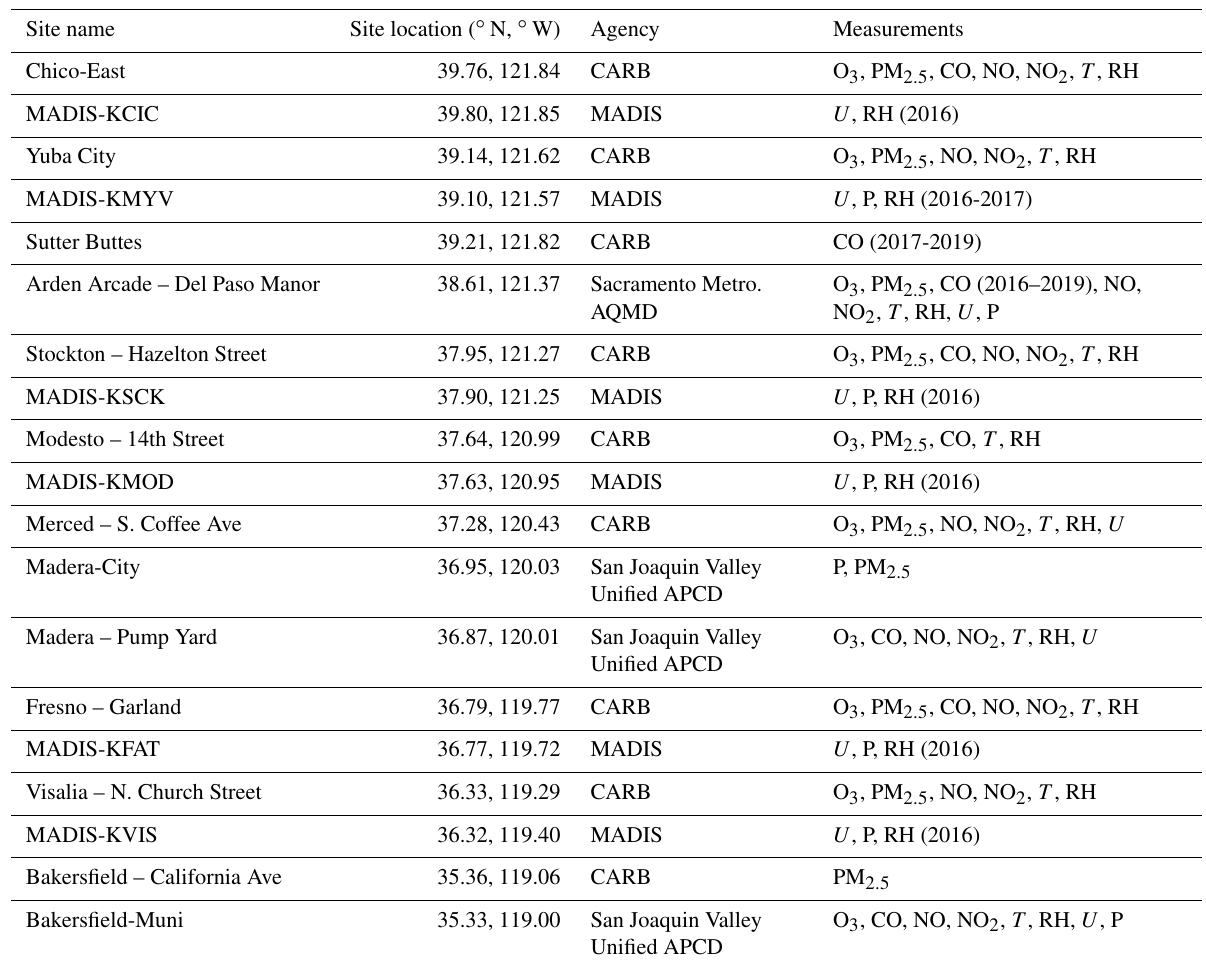
Table 1. The locations of measurement sites and detailed information. Site